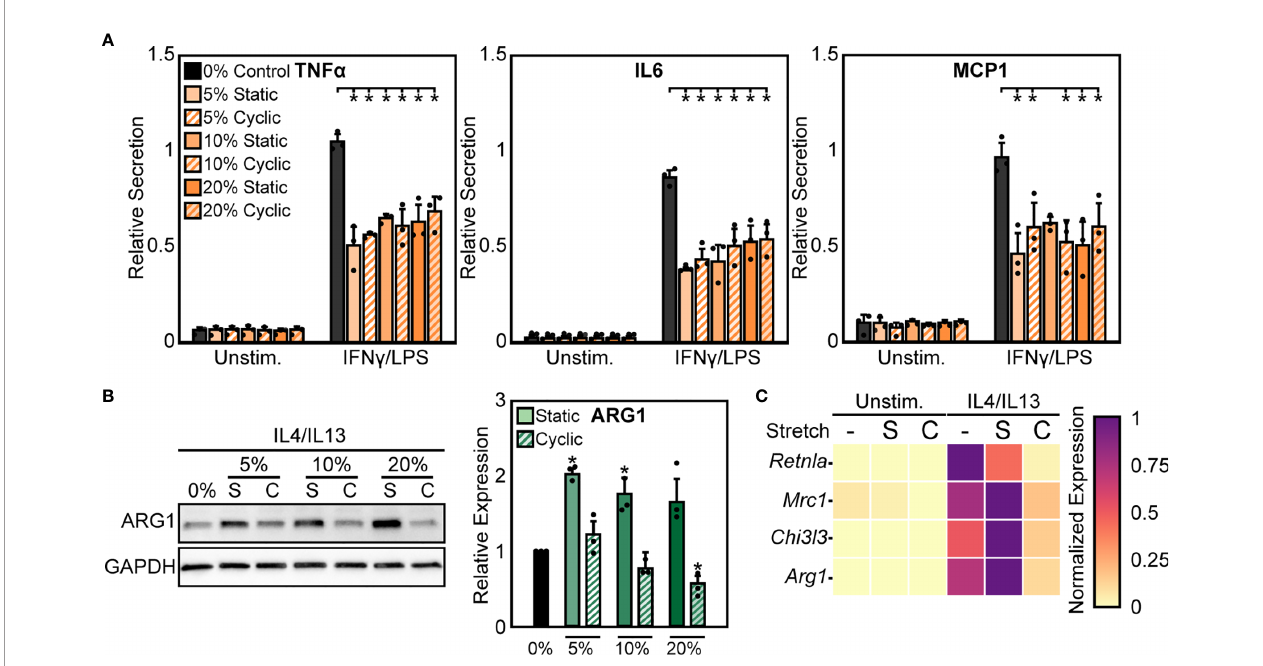
FIGURE 2 | Static and cyclic stretch differentially regulate macrophage in fl ammatory and healing activation. (A) Secretion of TNF a , IL6, and MCP1 for unstimulated and IFN g /LPS stimulated macrophages exposed to 0%, 10%, and 20% static and cyclic strains. Values are normalized to a 0% stretch and IFN g /LPS stimulated internal control within each biological replicate. (B) Representative western blots (left) and quanti fi cation (right) of ARG1 expression for three independent experiments in IL4/IL13 stimulated macrophages exposed to 0%, 10%, and 20% static and cyclic stretch conditions for 18 hrs. Values normalized and statistical comparisons made to IL4/IL13 stimulated condition. (C) Gene expression of Arg1 , Chi3l3 , Mrc1 , and Retnla for unstimulated and IL4/IL13 stimulated macrophages exposed to 0% (-), 20% static (S), and 20% cyclic (C) strains. Data represents three independent experiments and made relative to the highest expressing condition within each gene. Error bars indicate standard deviation of the mean for three separate experiments and * p < 0.05 when compared to the indicated condition as determined by Student ’ s t-test (A) or paired t-test with Bonferroni correction used for multiple comparisons (B)